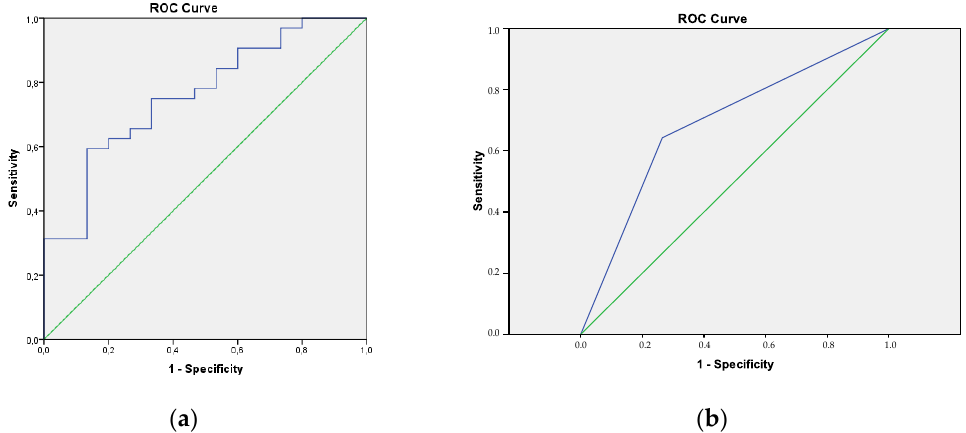
Figure 4. ROC curve to assess the specificity and sensitivity of total IgE vs. ImmunoCAP Phadiatop/fx5 ( a ) and total IgE vs. Euroimmun paediatrics ( b ).